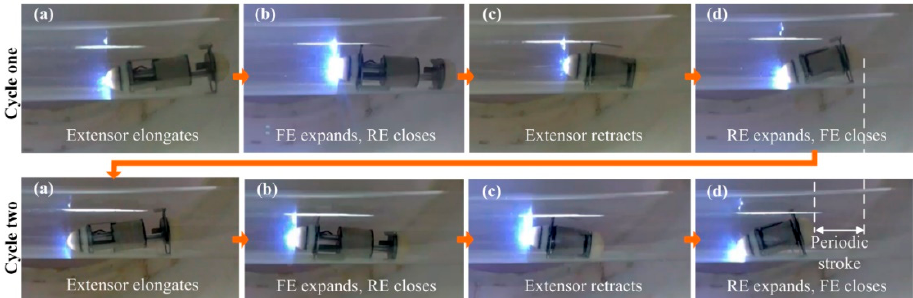
Figure 8. Movement snapshots of the enhanced ILCR in two cycles. Each cycle contains four gaits of ( a – d ) that last about 6 s, 1 s, 6 s, and 1 s, respectively. In the gait sequence of ( a – d ), the ILCR moves forward; in the reverse sequence, the ILCR moves backward.